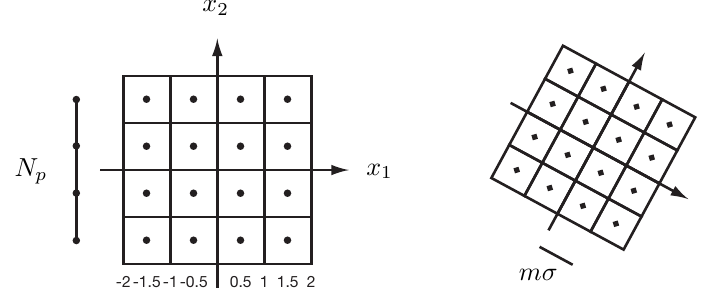
Figure 6. SIFT descriptor layout for 4 × 4 sub-regions.